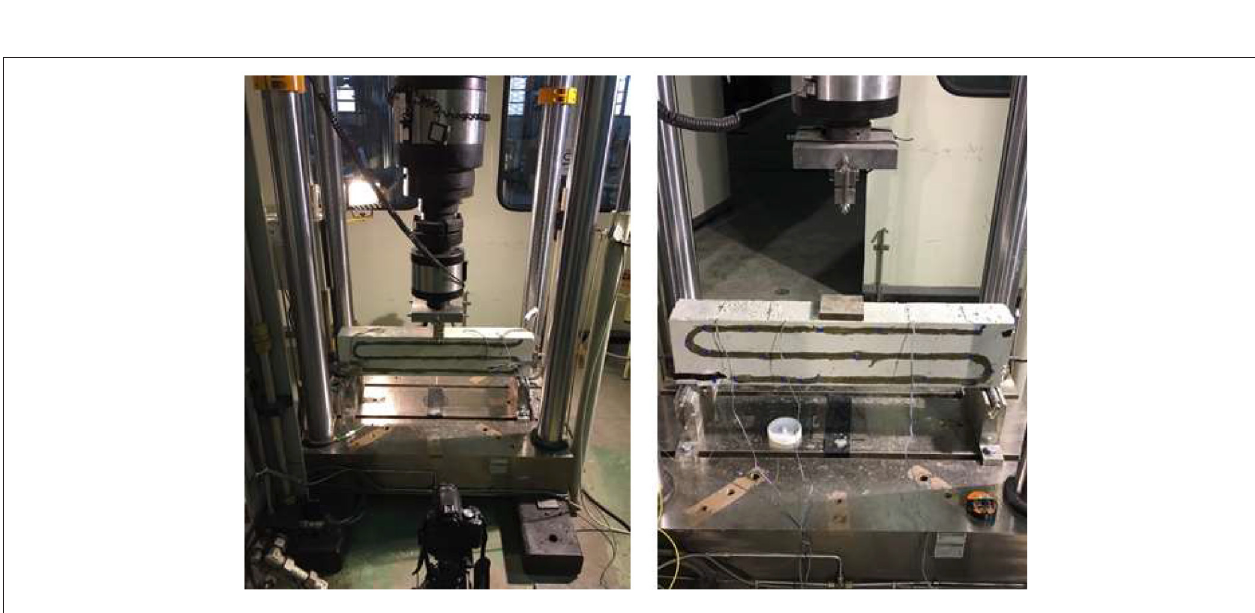
FIGURE 3 | Tested reinforced concrete beam 1 (Left) and beam 2 (Right) .